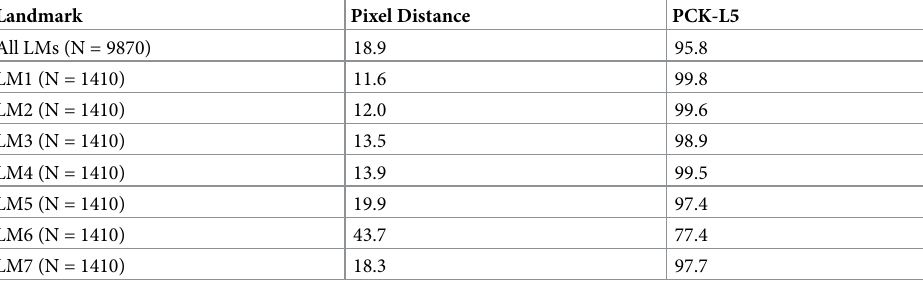
Table 1. The pixel distance and PCK-L5 for Littorina shells.